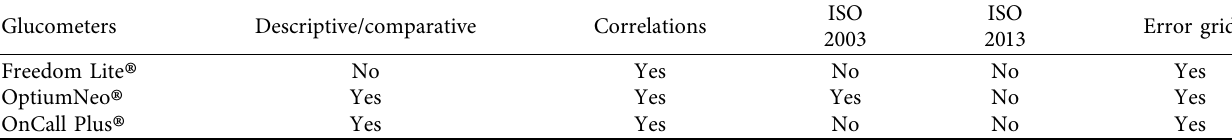
Table 7: Synthesis of the analysis of the efectiveness of glucometers in dogs’ blood samples.